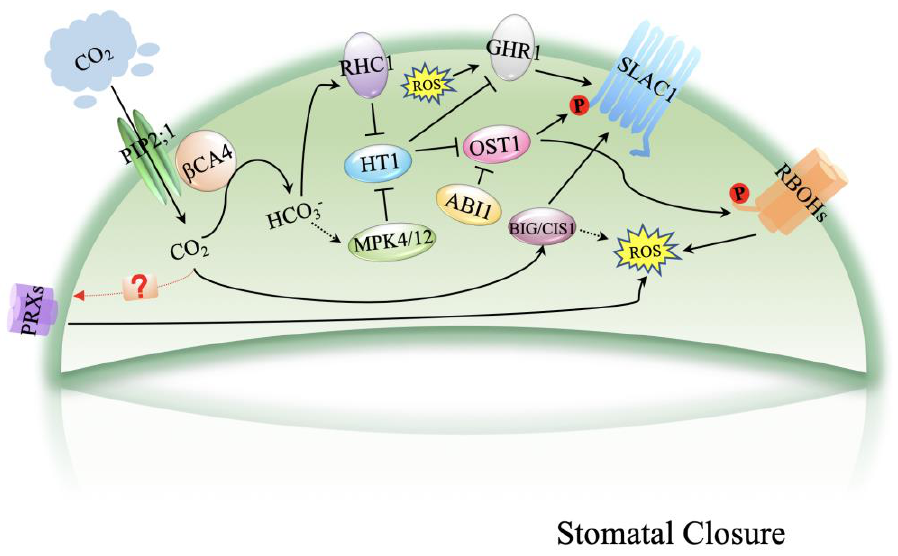
Figure 1. Schematic model of CO 2 -induced stomatal closure. CO 2 has been transported by PIP2;1 and converted into HCO 3- by βCA4, which is located at the plasma membrane and interacts with PIP2;1. The accumulation of cytosolic HCO 3- leads to the suppression of HT1 by MPK4/12 and RHC1. Repressed HT1 inhibits OST1, resulting in the activation of SLAC1. OST1 phosphorylates respiratory burst ROBHs to produce ROS and induces stomatal closure. GHR1 is an inactive pseudokinase that mediates the activation of SLAC1. BIG1 activates SLAC1 when cytosolic HCO 3- accu- mulates and produces ROS that induce stomatal closure. PRXs, peroxidases; RBOHs, respiratory burst oxidase homologs; PIP2;1, plasma membrane intrinsic protein 2;1; βCA4, beta carbonic anhydrase 4; RHC1, resistance to high CO 2 ;HT1, high leaf temperature 1; MPK4/12, protein kinase 4/12; OST1, open stomata 1; ABI1, ABA insensitive 1; BIG1, CO 2 insensitive 1 GHR1, guard cell hydrogen peroxide- resistant 1; SLAC1, slow anion channel-associated 1; ROS, reactive oxygen species; P, phosphorylation.